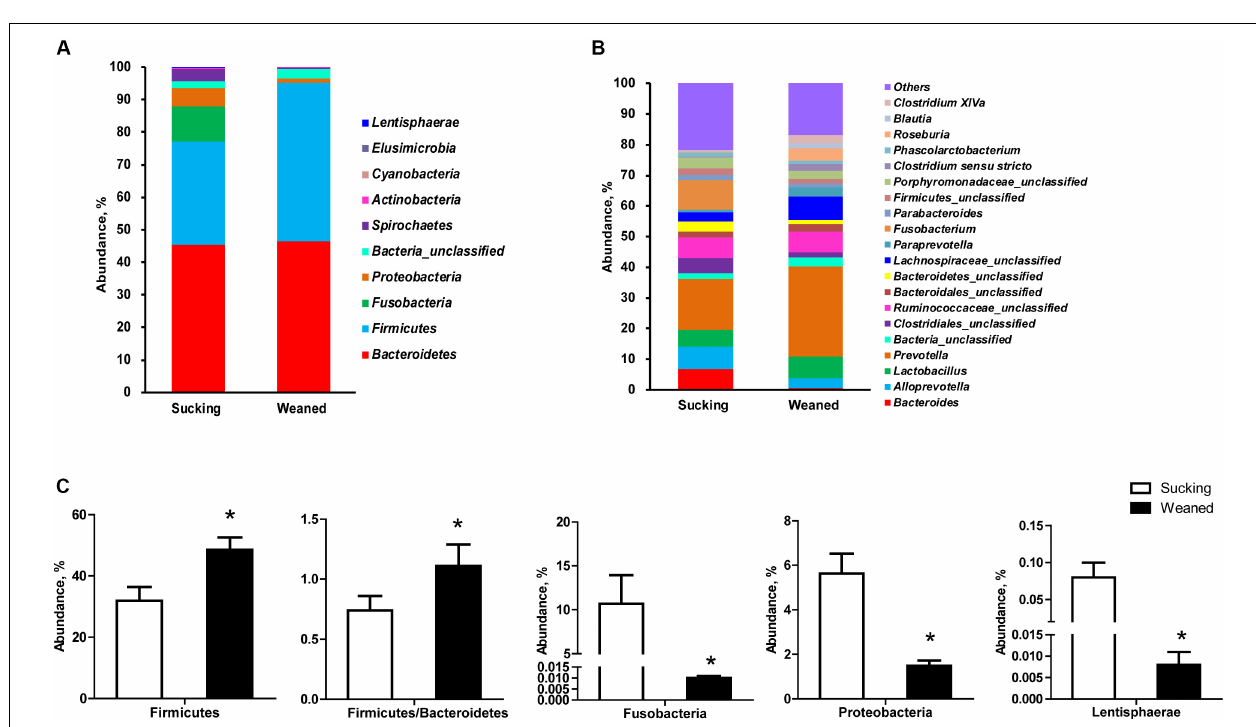
FIGURE 8 | Gut microbiota composition of sucking piglets and weaned piglets. (A) Gut microbiota composition at the phylum level. (B) Gut microbiota composition at the genus level. (C) Different microbes at the phylum level between sucking piglets and weaned piglets. All values are expressed as the means ± SEMs ( n = 5–6). * P <